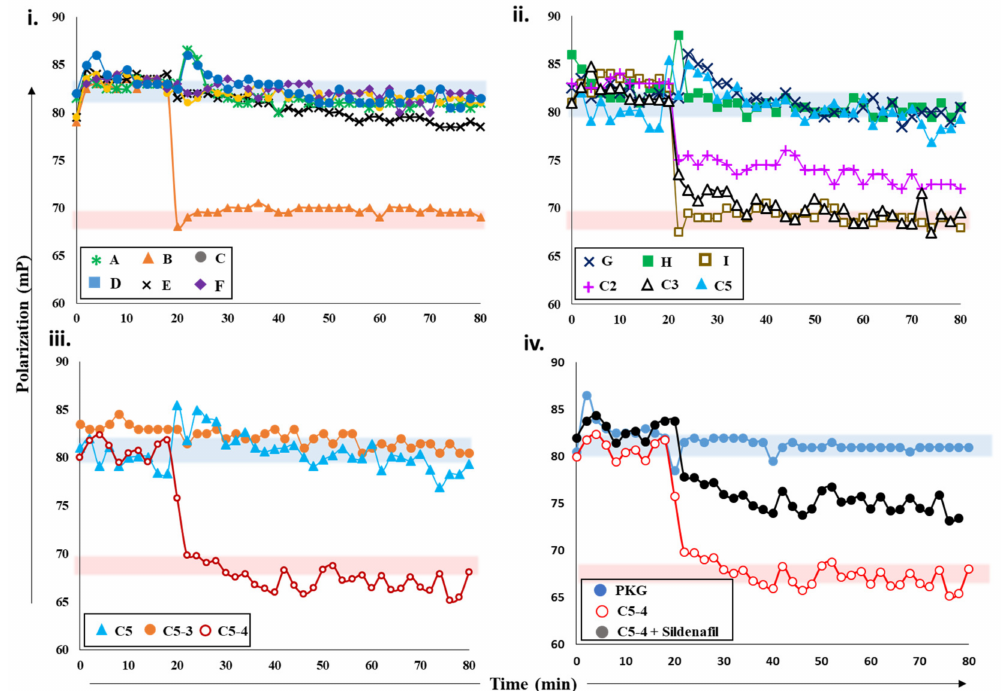
Figure 3. Effects of plant extracts and fractions on PDE5 activity. ( i ) Fluorescence polarization versus time plot depicting the changes in FP values of 2fg-PKG upon addition of PDE5 (0.2 µ M) incubated with crude plant extracts A-F at 20 min time